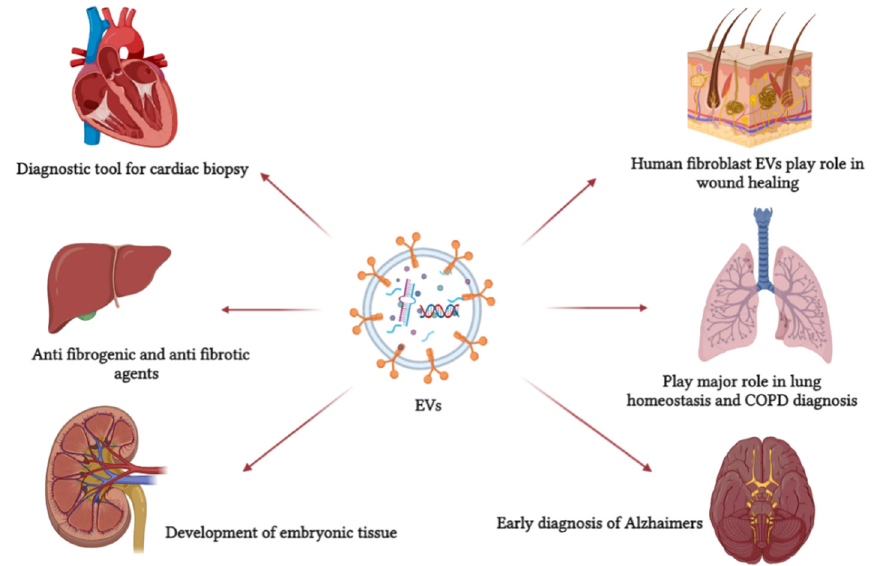
Figure 2. EVs are involved in several pathological and physiological processes. It can be used as a primary non-invasive diagnostic tool and, because of its role in cell communication, it can be used as a drug carrier. This figure refers to some EV functions in defense mechanisms, cellular communication, and normal physiological